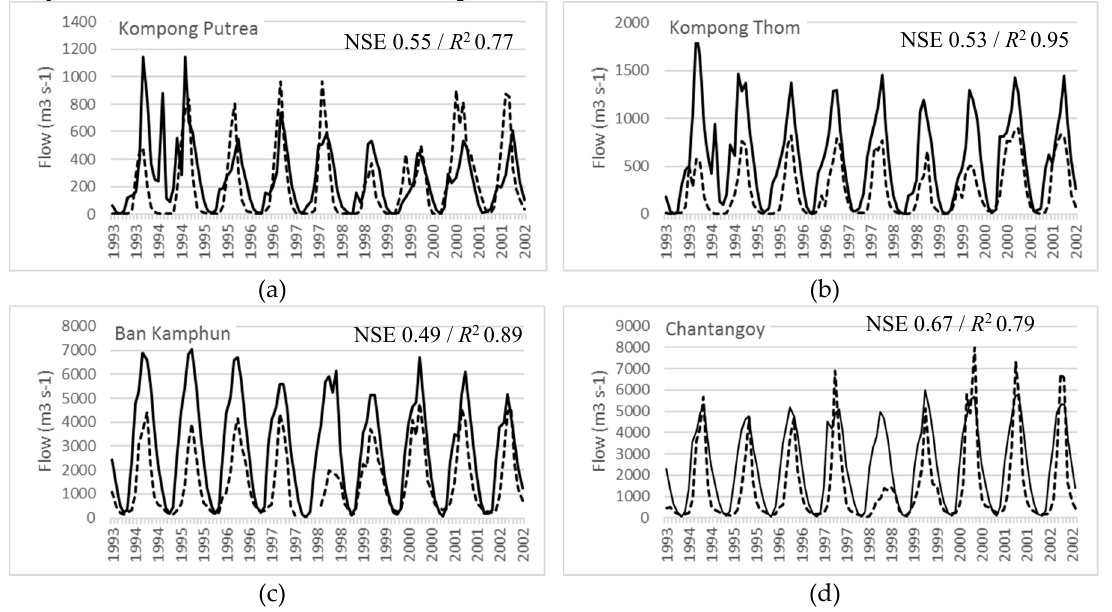
Figure 3. Calibration of the SWAT model’s discharge (flow) at 4 Mekong River Commission gauging stations (( a ) Kompong Putrea, ( b ) Kompong Thom, ( c ) Ban Kamphun, ( d ) Chantangoy). The line charts compare flow (m 3 s − 1 ) from the SWAT mode (dashed lines) with actual MRC Gauging stations flow (solid line).